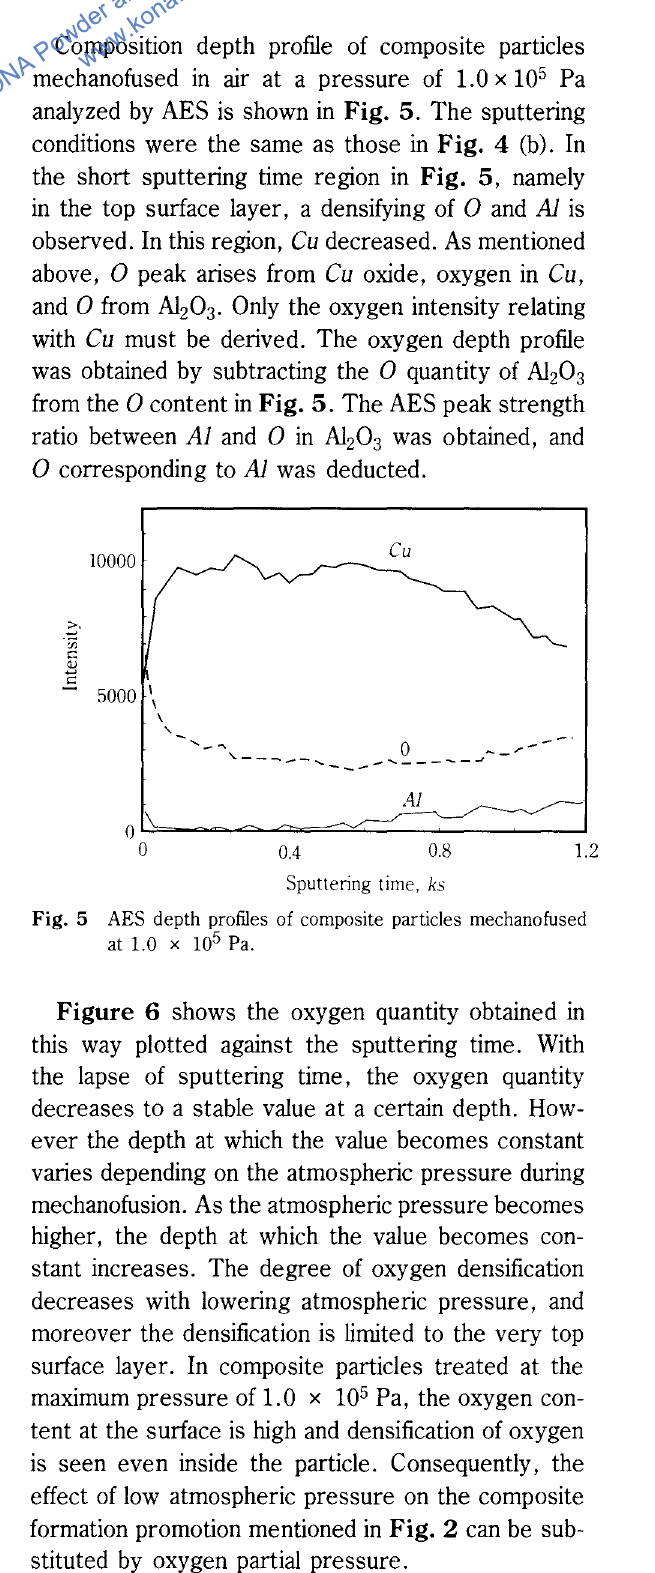
Fig. 7 SEM surface micrographs of the composite particles com pressed by cold